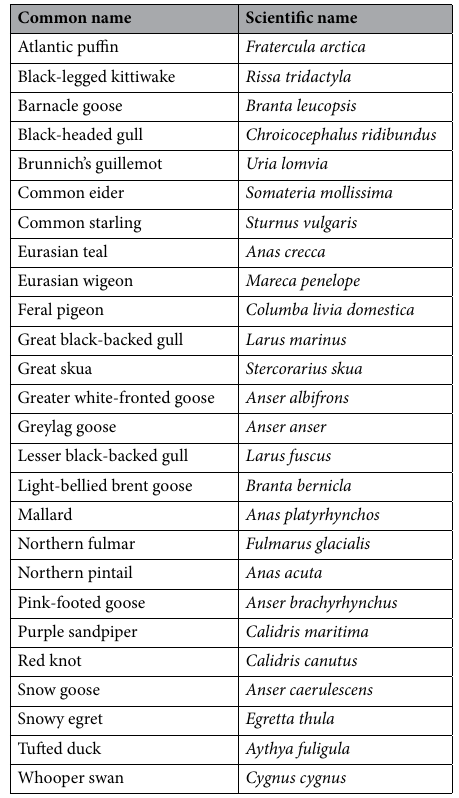
Table 2. Common and scientific species names of the birds mentioned in the